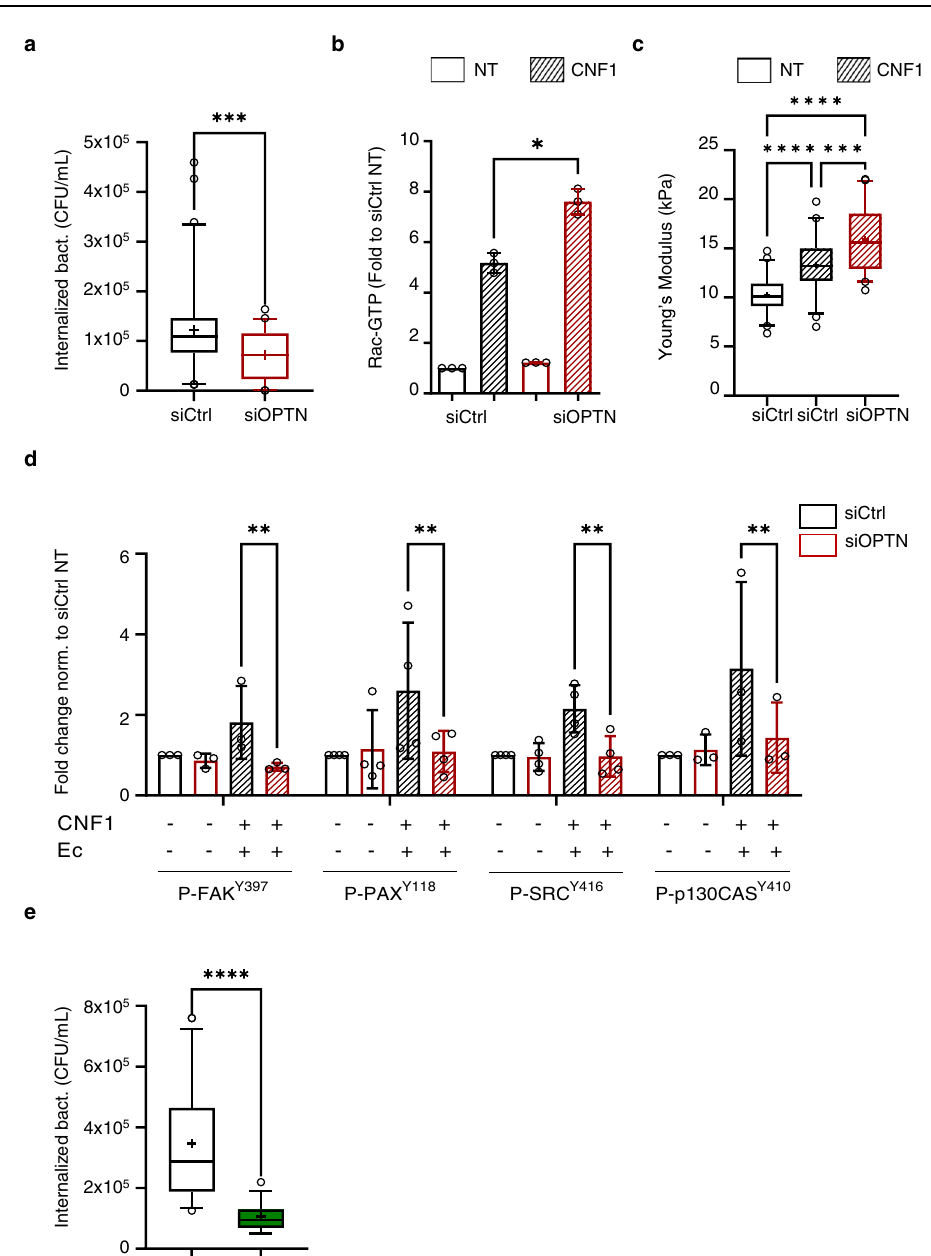
Fig. 6 | OPTN controls cellular invasion by Ec and impairs CNF1 and FimH- mediated mechanochemical signaling of integrins. a Quanti fi cation of inter- nalized Ec 30min after gentamicin treatment in siCTRL (control) or siOPTN (optineurin) HUVEC cells on plastic treated with 1 nM CNF1. Graph displays absolute CFU/ml. Boxplots of n = 5 independent experiments and three replicates per condition. Wilcoxon rank sum test (two-tailed): *** p = 0.004. b Rac1 activation in HUVEC transfected with siCtrl or siOPTN on plastic and either untreated (UT) or treated 2h with 1 nM CNF1 (CNF1), measured by GST- PAK af fi nity puri fi cation. Rac1-GTP levels were quanti fi ed and reported to total Rac1 and GAPDH. Fold change to untreated siCtrl condition, set to 1. Mean± SD, n = 3 independent experiments (single dots). One-way ANOVA with Dun- nett ’ s test for multiple comparisons: * p = 0.0460. c Cortical elastic modulus